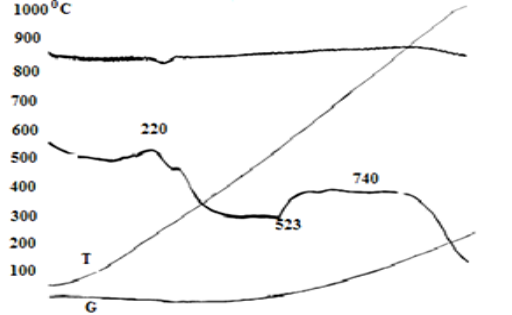
Fig. 2. DTA/TG curves of the Uvgundatsan iron ore. From Fig. 2, we can see that: A small amount of